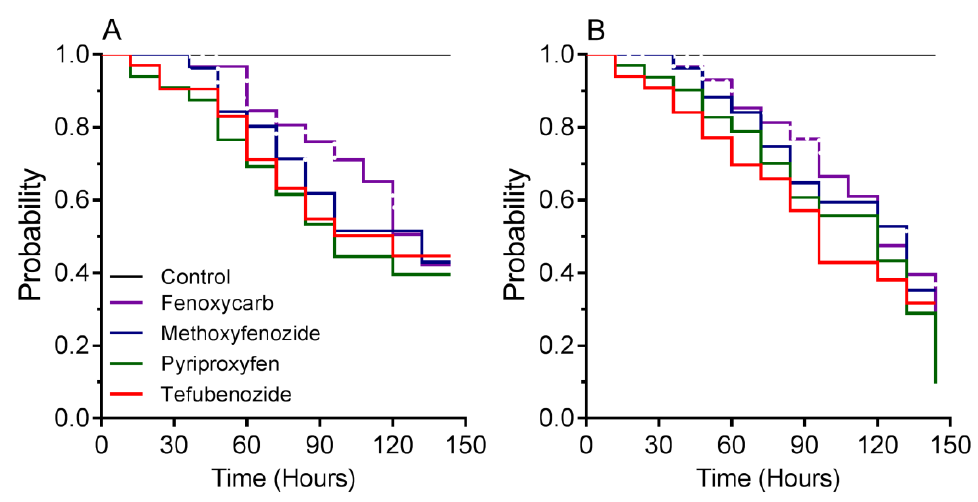
Figure 1. Kaplan – Meier survival curves for contact exposure of Euprosterna elaeasa larvae with insect growth regulators (IGRs) at different lethal concentrations: ( A ) LC 50 and ( B ) LC 95 .